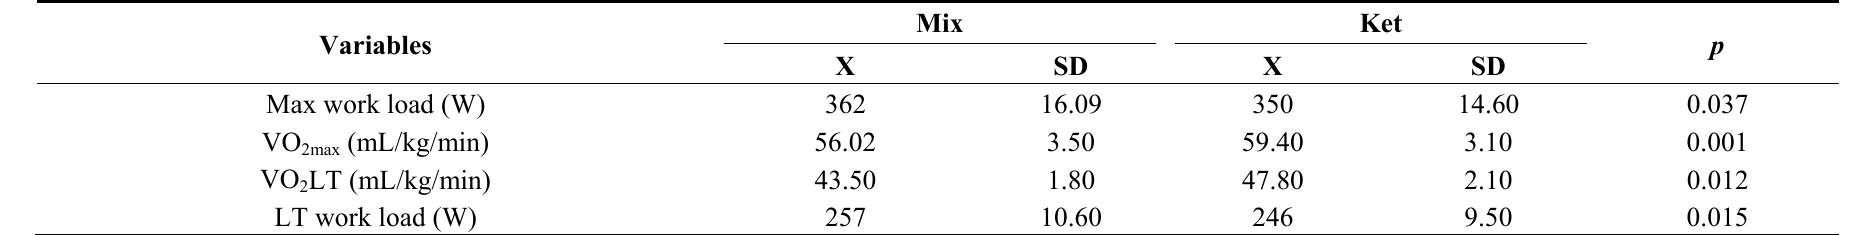
Table 7. Physiological variables (max work load, VO (Ket)